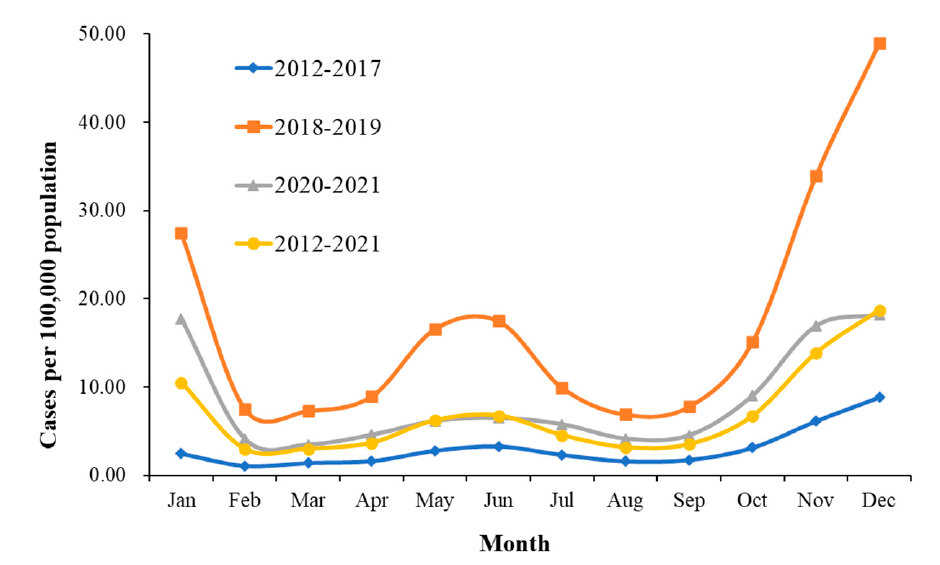
Figure 3. Incidence of varicella by month in Suzhou, 2012–2021.